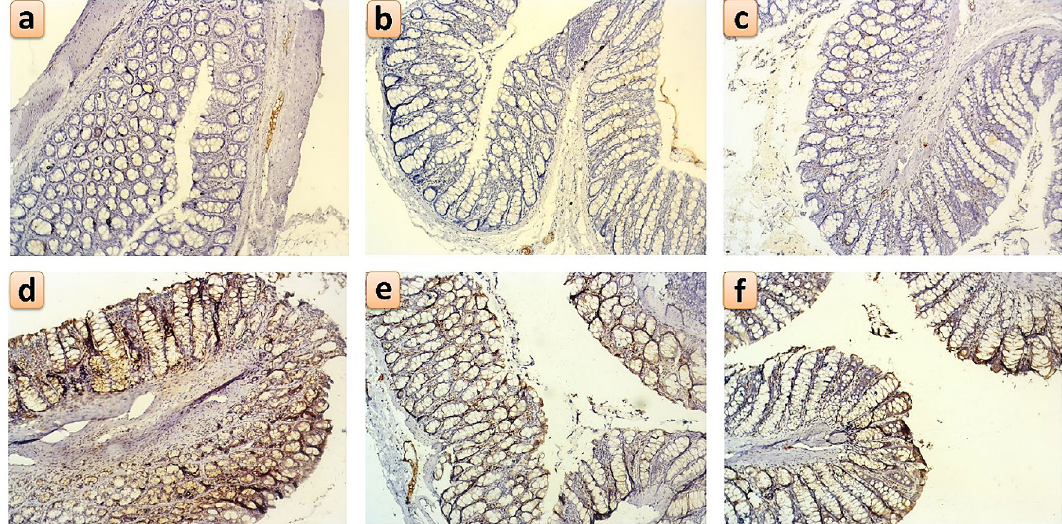
Figure 10. Immunohistochemical staining for Ki-67 positive cells within the colonic mucosa and submucosa following oral administration of B. amyloliquefaciens (BA) or BA-nanoparticles (BANPs) in non-colitic and colitic rats. Non-colitic groups including Control ( a ), BA ( b ) and BANPs ( c ) groups. While, colitic groups include DSS (d) , DSS + BA ( e ) and DSS + BANPs ( f ) groups